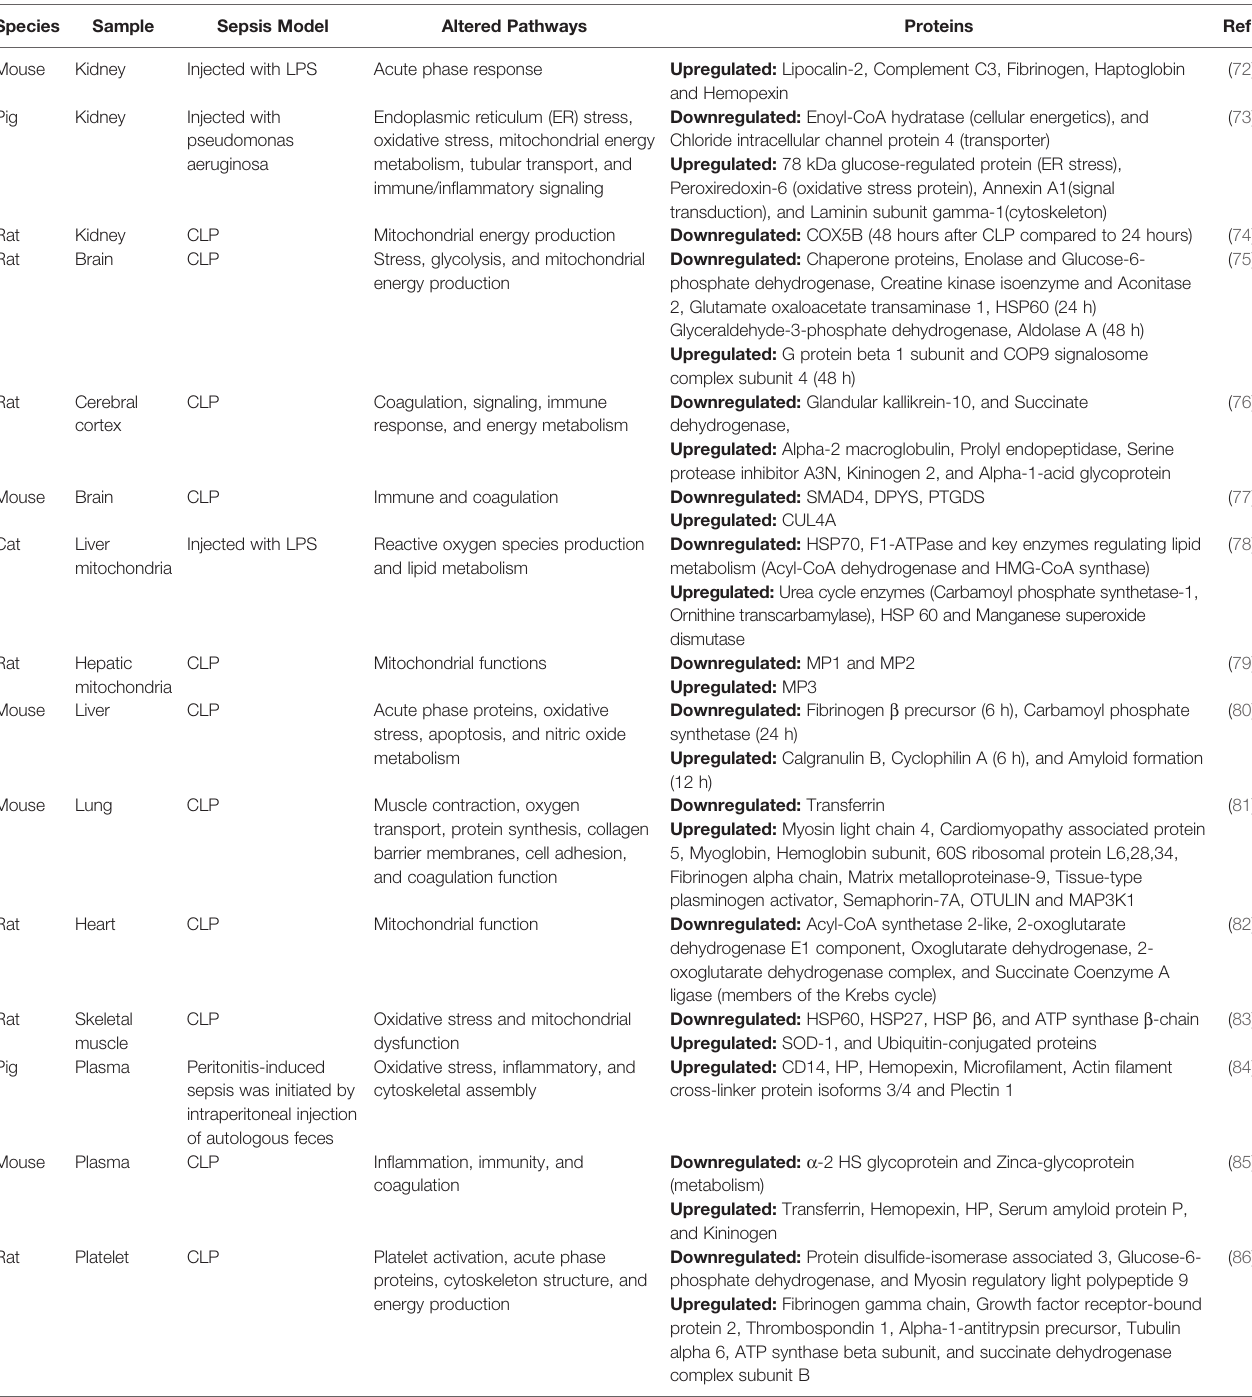
TABLE 1 | Summary of proteomics studies of sepsis infection using animal models. Species